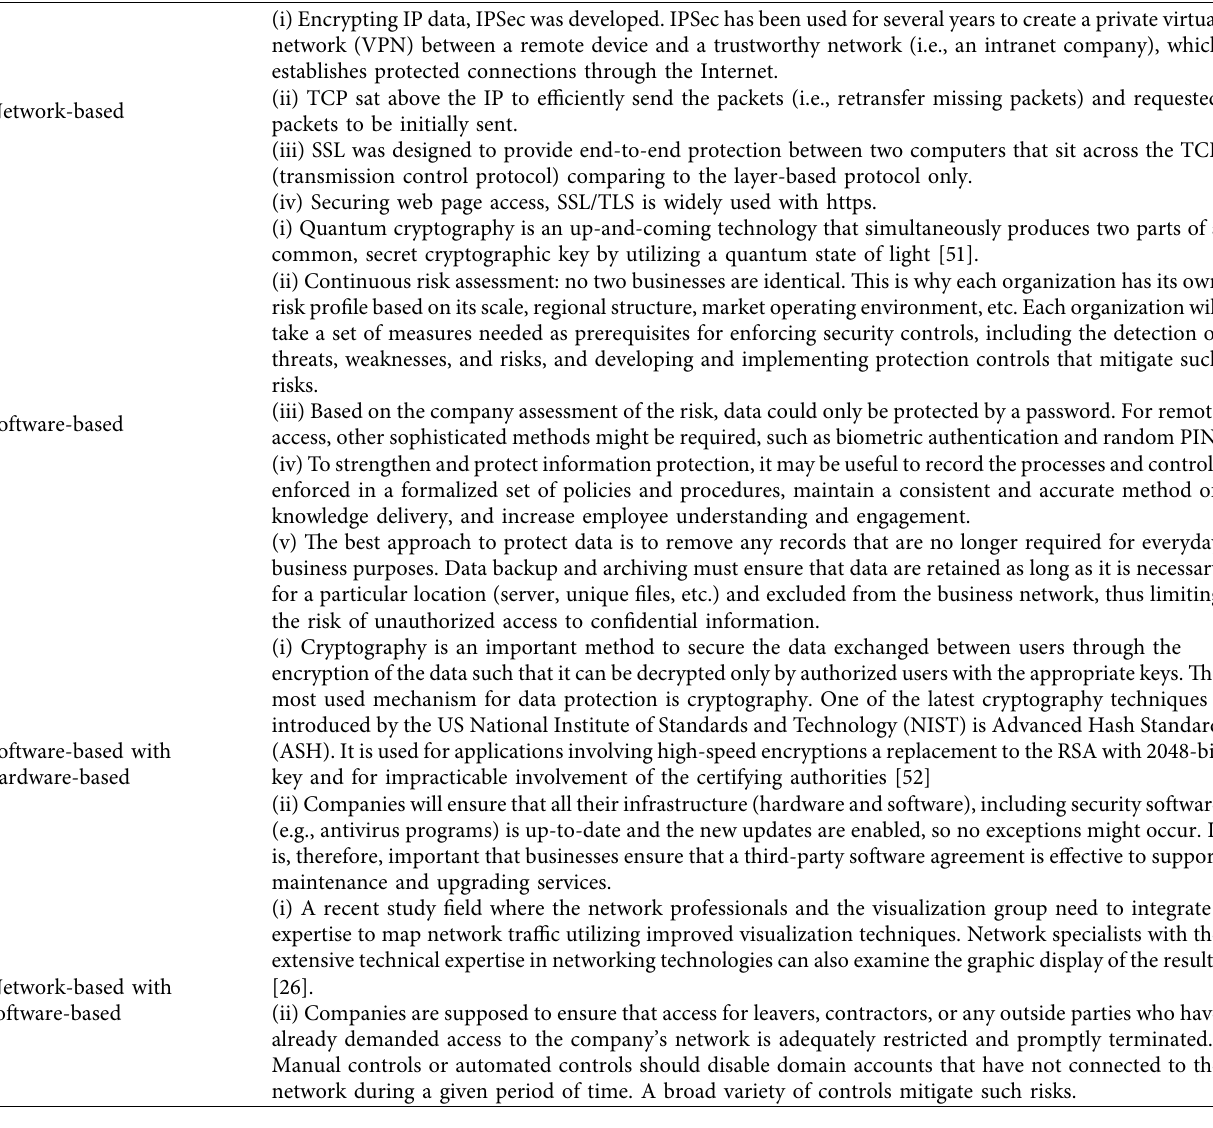
Table 2: Attacks’ defense strategies and the countermeasure techniques. Defense strategy Countermeasure techniques